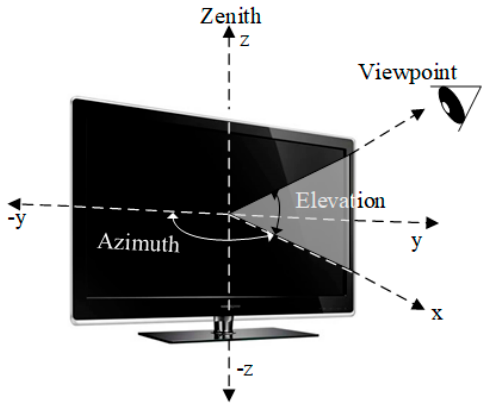
Figure 9. Angle of